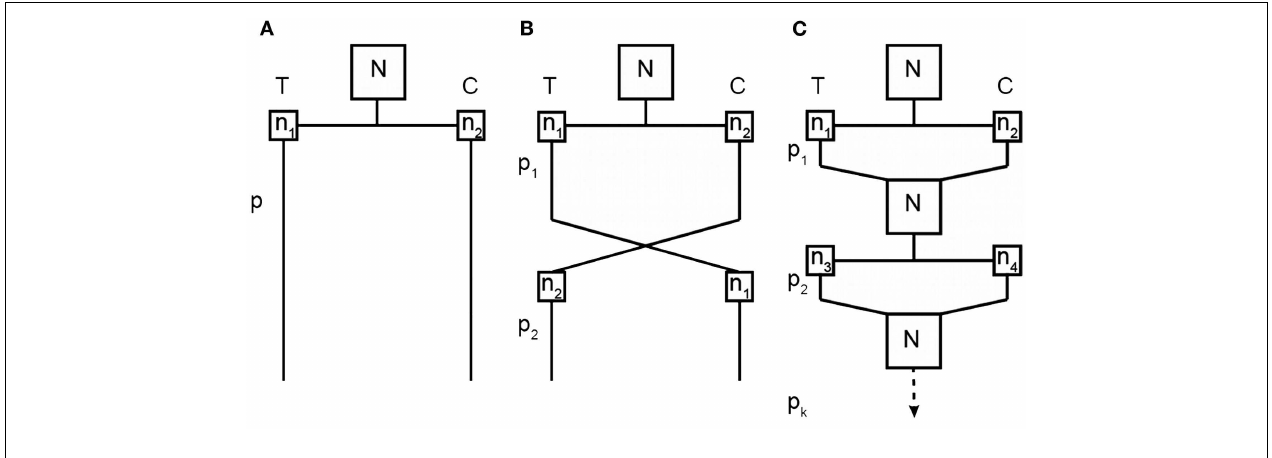
particular treatment condition at a particular time point (with subscripts differentiating between unique groups of subjects); and p is the treatment period (with subscripts identifying which treatment